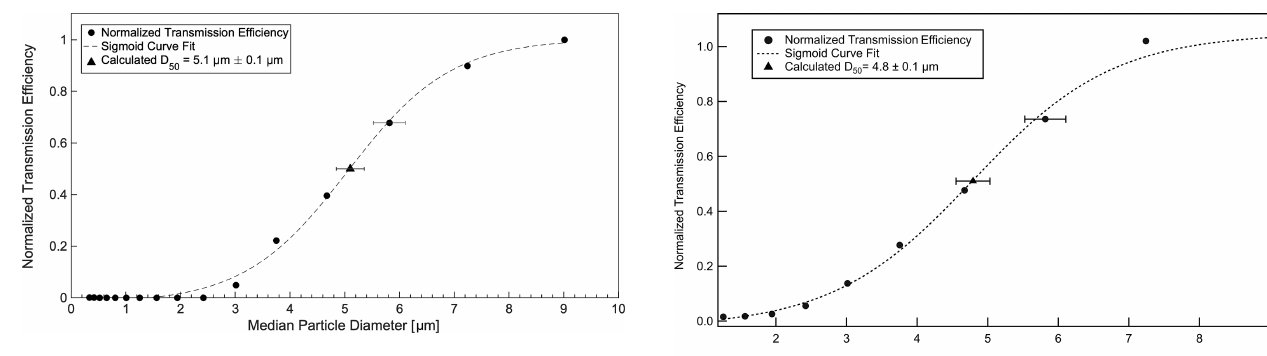
Figure 8. Transmission efficiency from the PCVI as a function of particle diameter (solid circles) fit with a sigmoid (dashed line). The triangle represents the size at which 50% of particles are transmit- ted (the experimental D50). The representative error, ± 5% due to instrument uncertainty as specified by the manufacturer, is shown on a point close to the D50 and on the D50.